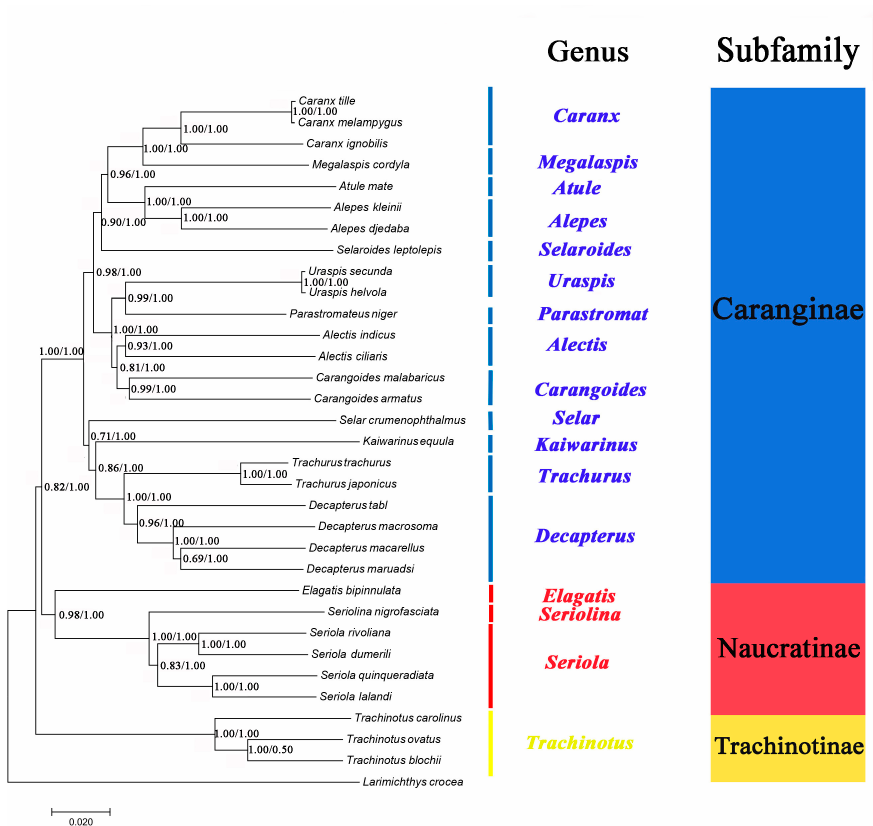
Figure 7. Phylogenetic tree inferred from the amino acid sequences of 13 PCGs of 32 species of Carangidae. Larimichthys crocea was used as the outgroup. The numbers at the nodes are the bootstrap support values (left) and Bayesian posterior probabilities (right).